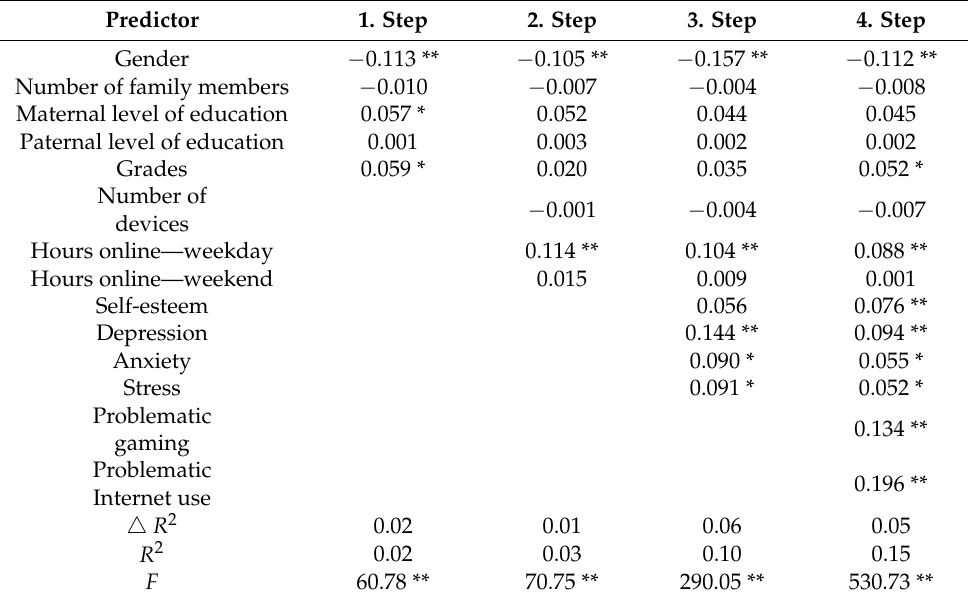
Table 10. HRA with committing as criteria.